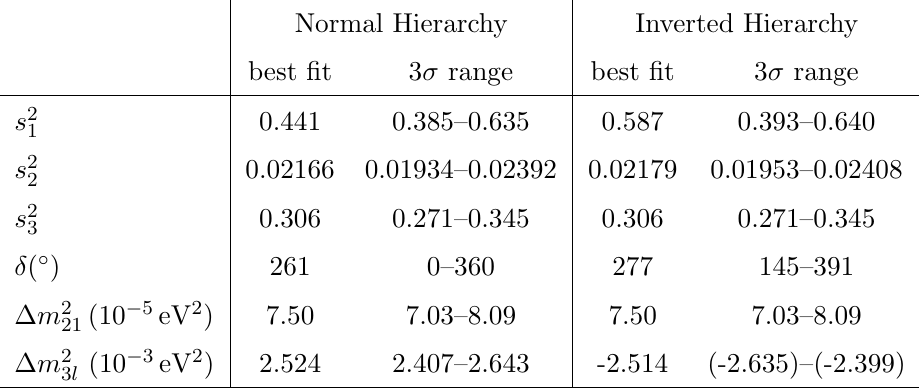
Table 1 . Best (cid:12)t values of neutrino parameters taken from the global (cid:12)t in ref. [35]. best (cid:12)t